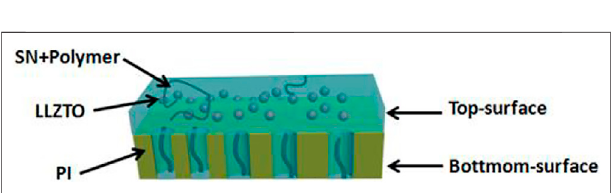
SCHEME 1 | The scheme of asymmetric organic-inorganic composite solid-state electrolyte.